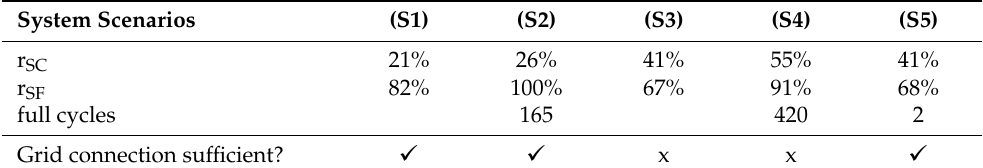
Table 3. Overview of considered system scenarios S1 to S5 in the building block. The considered battery operation strategies either maximise self-consumption (max. SC) or minimise the peak load on the grid connection (min. PL).